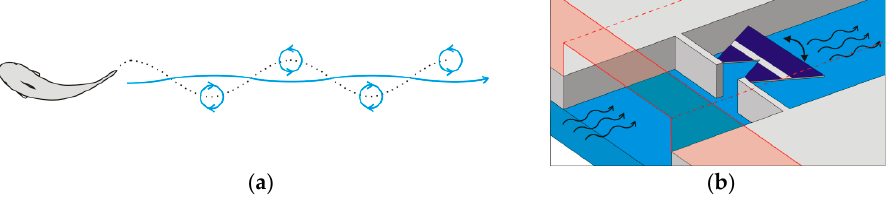
Figure 1. ( a ) The superposition of the vortices generated at the transition points of the oscillating tail fin results in an axial jet stream behind the swimming fish. ( b ) Schematic micro flapper mounted inside a micro channel: By undulatory up- und down-motion a directed air flow is generated.